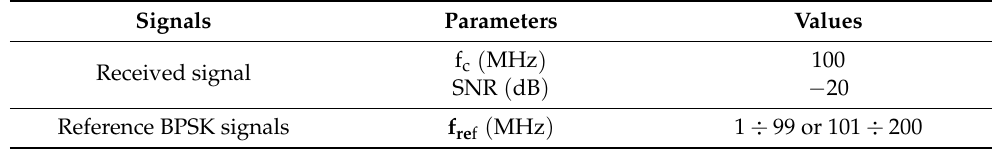
Figure 4. The CCF between the received and first set of reference signals: ( a ) f c > f ref ( b ) f c < f ref . 1 Table 1. Signal parameters for the first simulation.